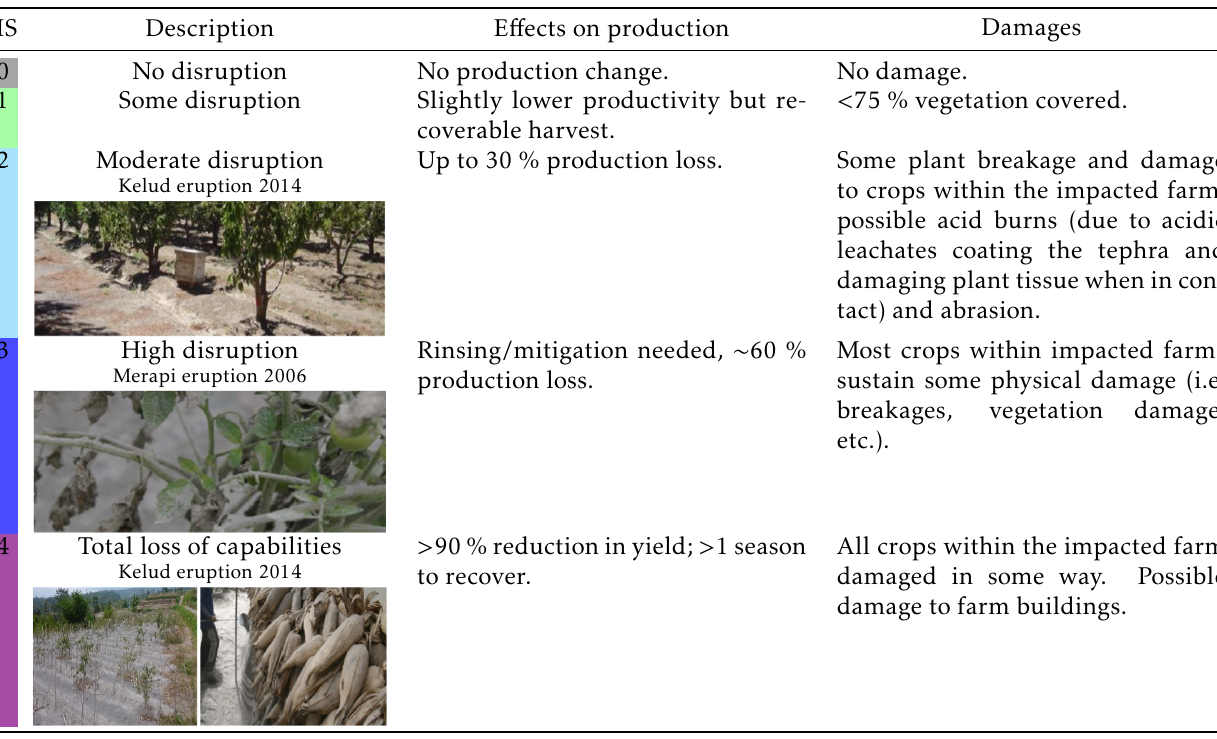
Table 5: Impact state (IS) scheme for horticultural farming with example photographs from post-event impact assessments. Photographs show farms impacted by previous eruptions that are representative of each IS.